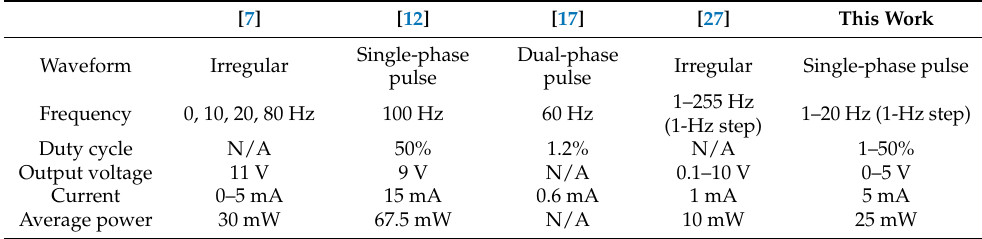
Table 1. The comparisons between existing research results with our work in stimulus parameters.